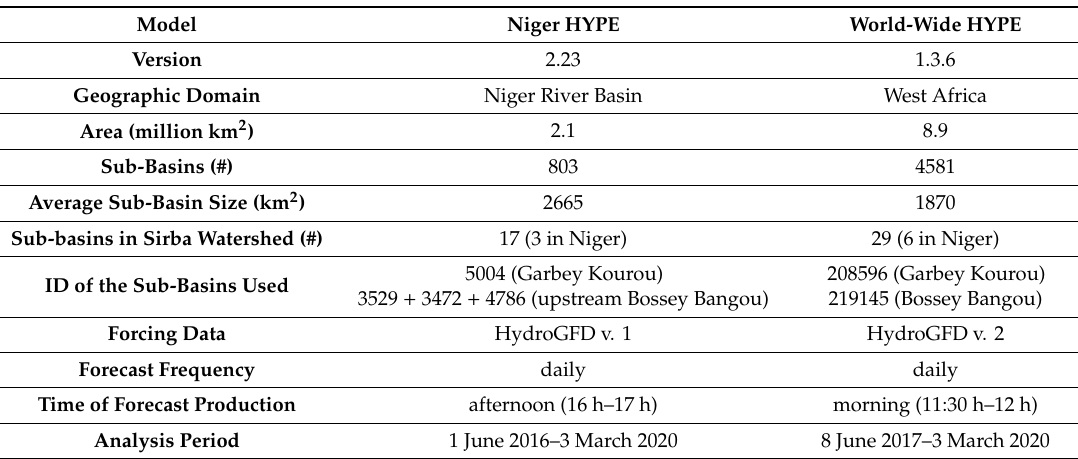
Table 1. Main features of Niger HYPE and World-Wide HYPE